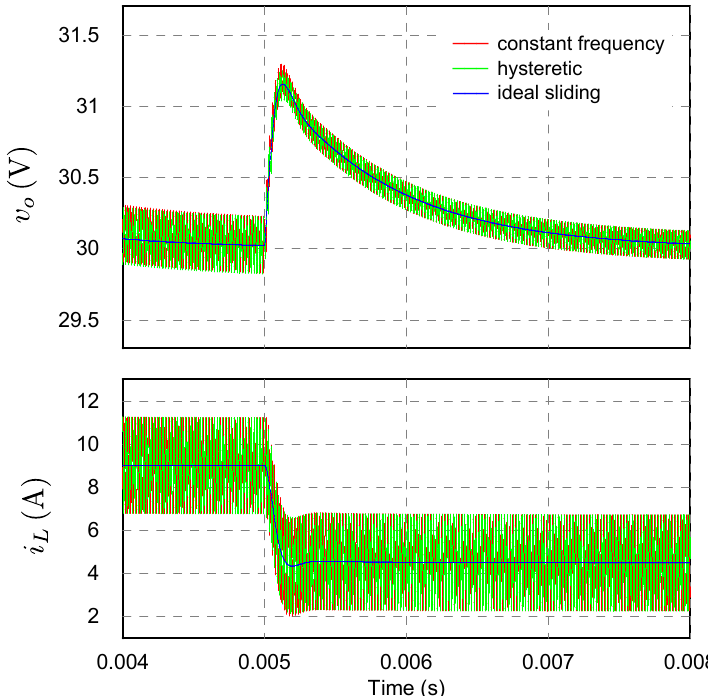
Figure 8. Response of the state variables v o and i L of the boost converter in closed-loop to a step change of 1.5A in i d ( t ) . Comparison of the ideal sliding-mode dynamics with that corresponding to two different types of control methods at finite switching